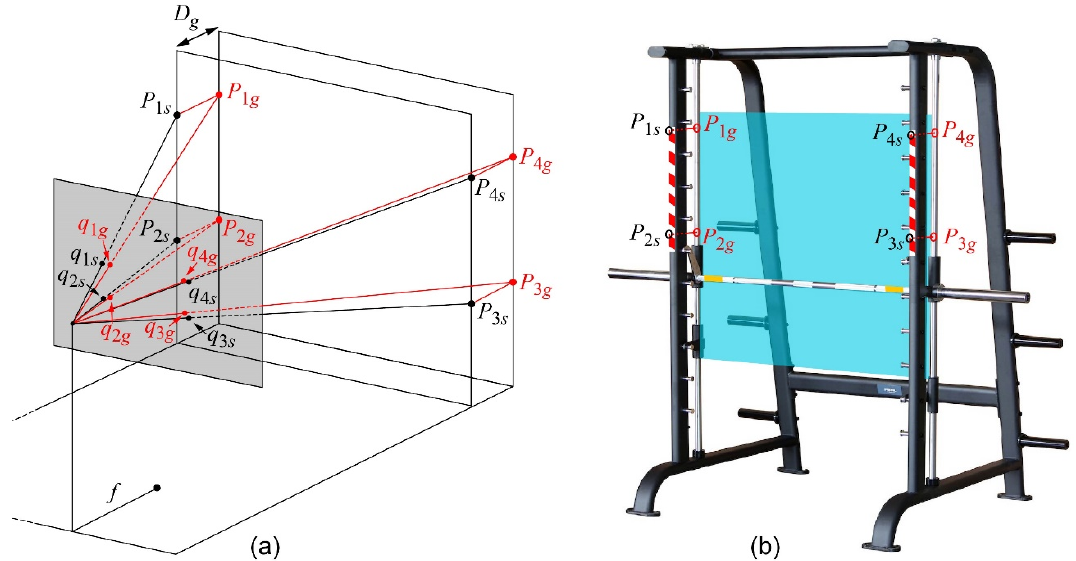
Figure 3. Homography transformations for the measurement of the true magnitude of the barbell movement. ( a ) Model showing the structural H s and guide H g homographies with reference points in the structural pillars P 1 s to P 4 s and guide pillars P 1 g to P 4 g , respectively. ( b ) Location of the reference points in the multipower machine.